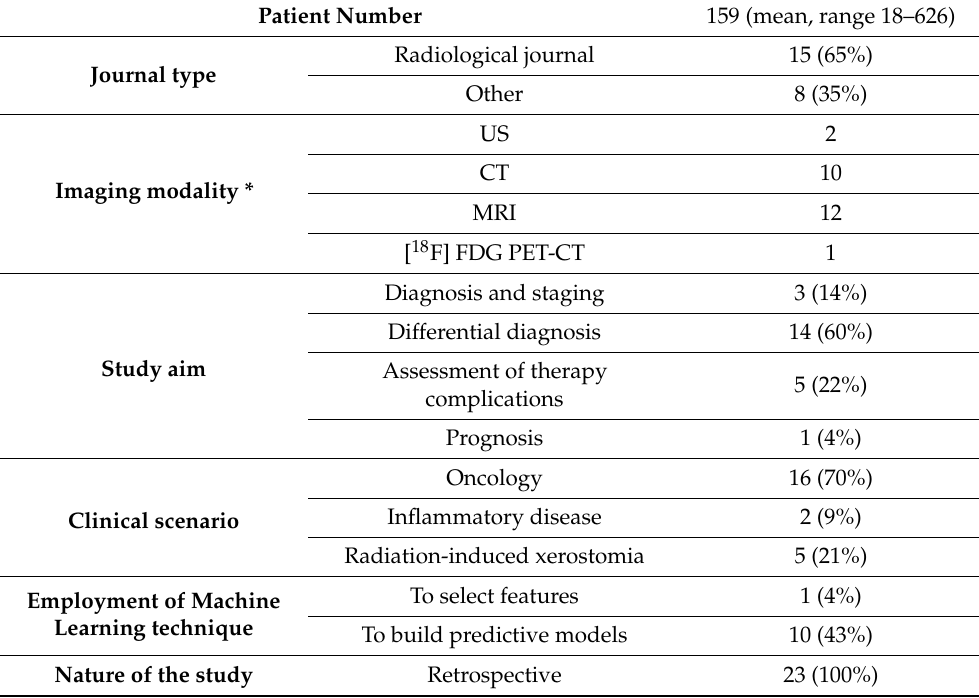
Figure 2. Distribution of reviewed papers from 2017 up to 2021. The characteristics of the included articles are summarized in Table 2. Table 2. Characteristics of included